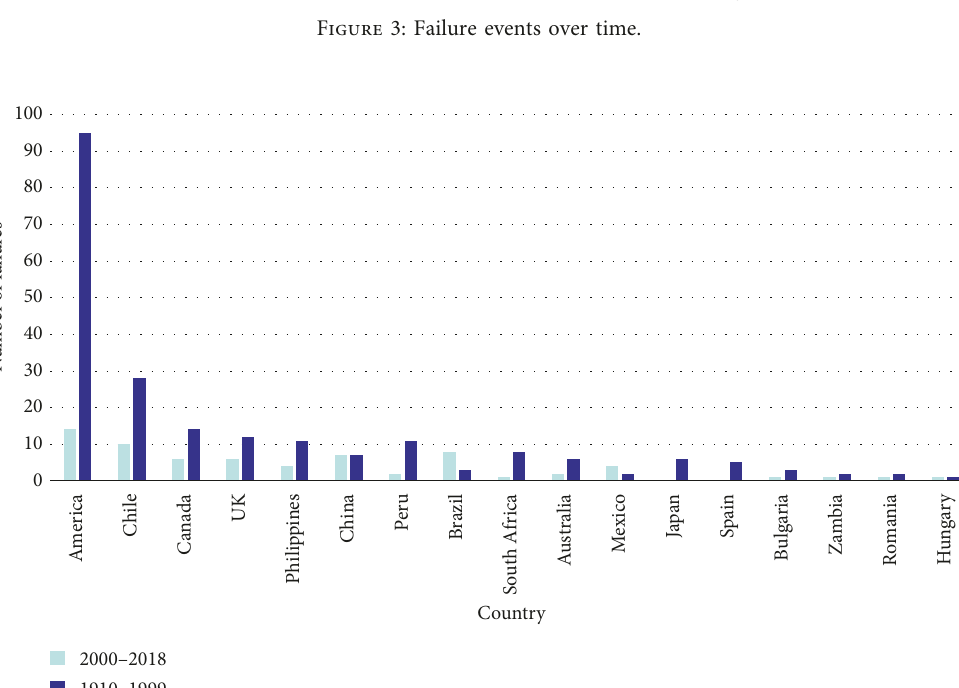
Figure 3: Failure events over